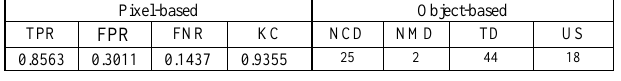
Table 2. Evaluation of the change detection